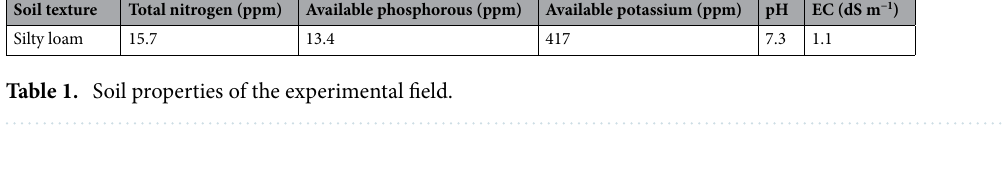
Type of organic